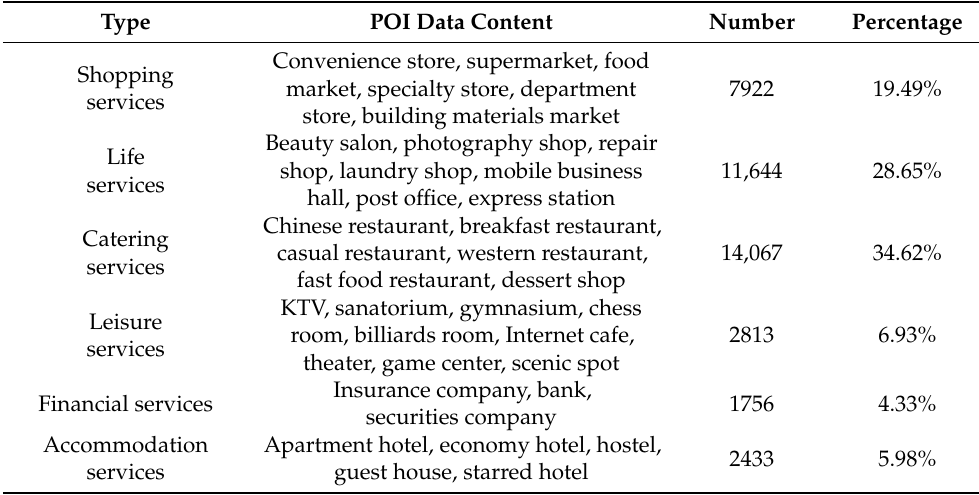
Table 1. The classification and statistics of market services industries’ POI data in Wuhan city’s new urban districts.